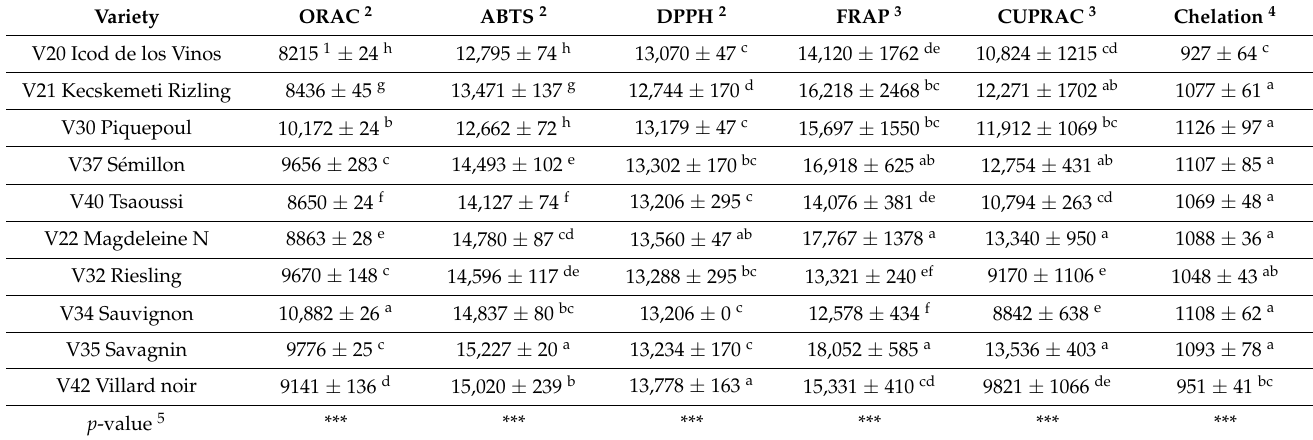
Table 1. Antioxidant activities of polyphenol-enriched grape stems extracts using ORAC, ABTS, DPPH, FRAP, CUPRAC and iron chelation activity. 1 Means within a column (n = 3) followed by dif- ferent letters differ significantly (Kruskal–Wallis one-way ANOVA on ranks and Fisher LSD, p < 0.05). 2 Expressed as Trolox equivalent antioxidant capacity ( µ mol TEAC.g − 1 of extract). 3 Expressed as Ascorbic acid equivalent antioxidant capacity ( µ mol Ascorbic acid · g − 1 of extract). 4 Expressed as fixed iron ( µ M · g − 1 of extract). 5 Effect of the grape stems variety on the antioxidant activity (*** p <